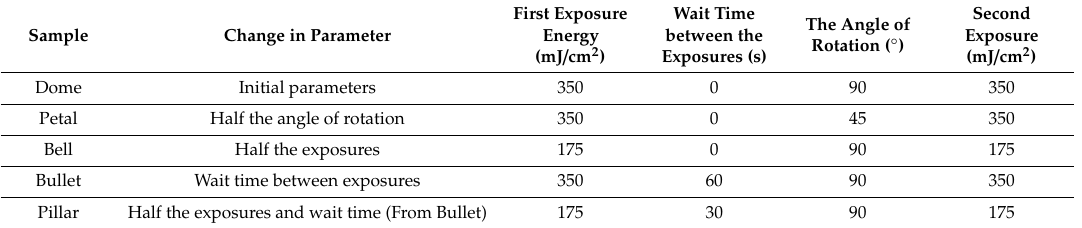
Table 1. Fabrication parameters. Plain polydimethylsiloxane (PDMS), without any microstructure array (MSA), is defined as the control. Samples are named after the microstructure